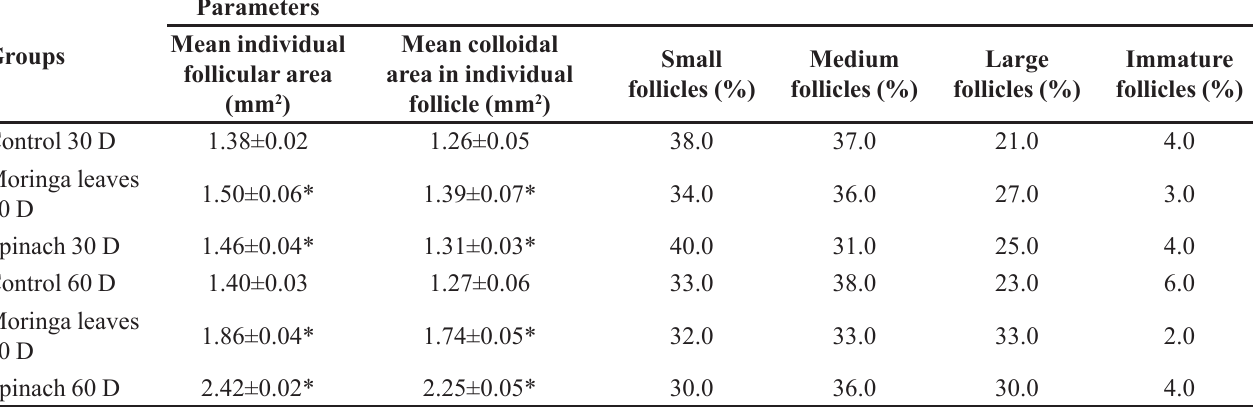
TABLE III - Morphometric/ histometric and semiquantitative assessment of thyroid follicles of experimental animals under the influence of selected plant foods fed for 30 days and 60 days